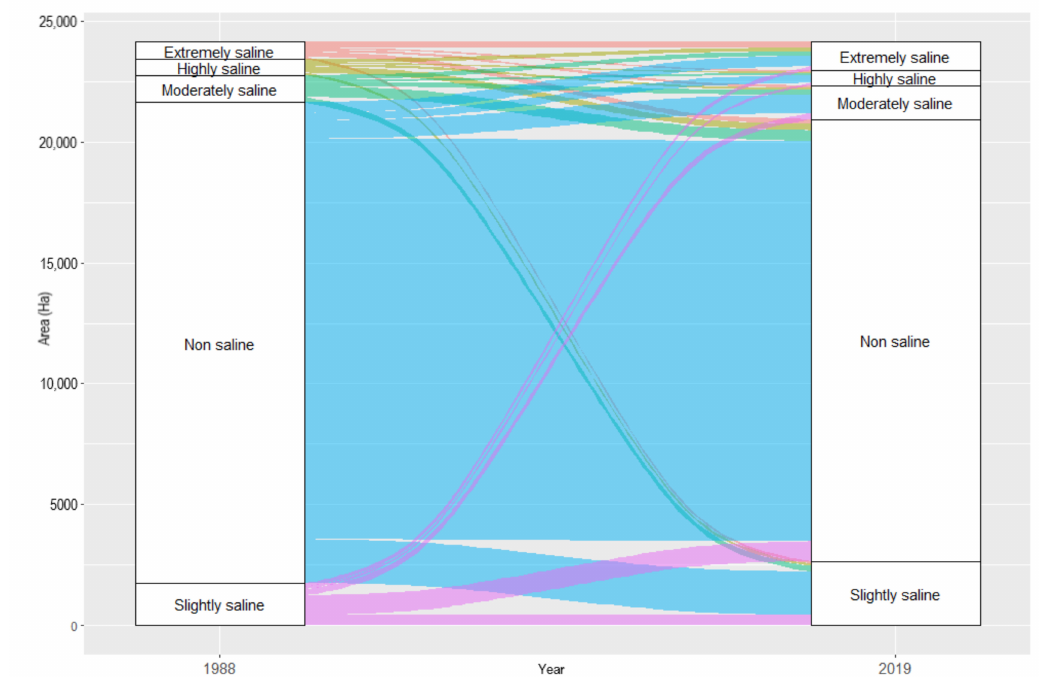
Figure 5. Sankey diagram for comparison of salt-affected land dynamics from salinity distribution maps for the years 1988 and 2019 in Jaffna Peninsula.